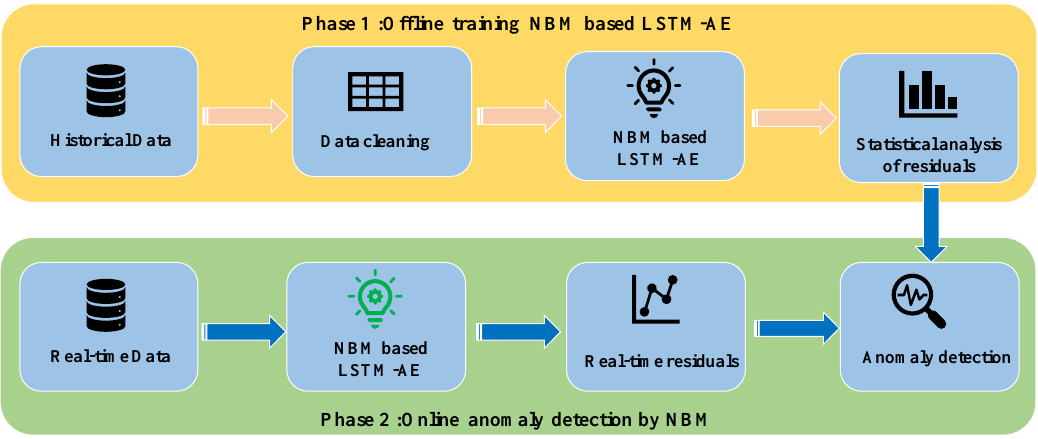
Figure 1. Anomaly detection framework based on the long short-term memory-based autoencoder (LSTM-AE) neural network .